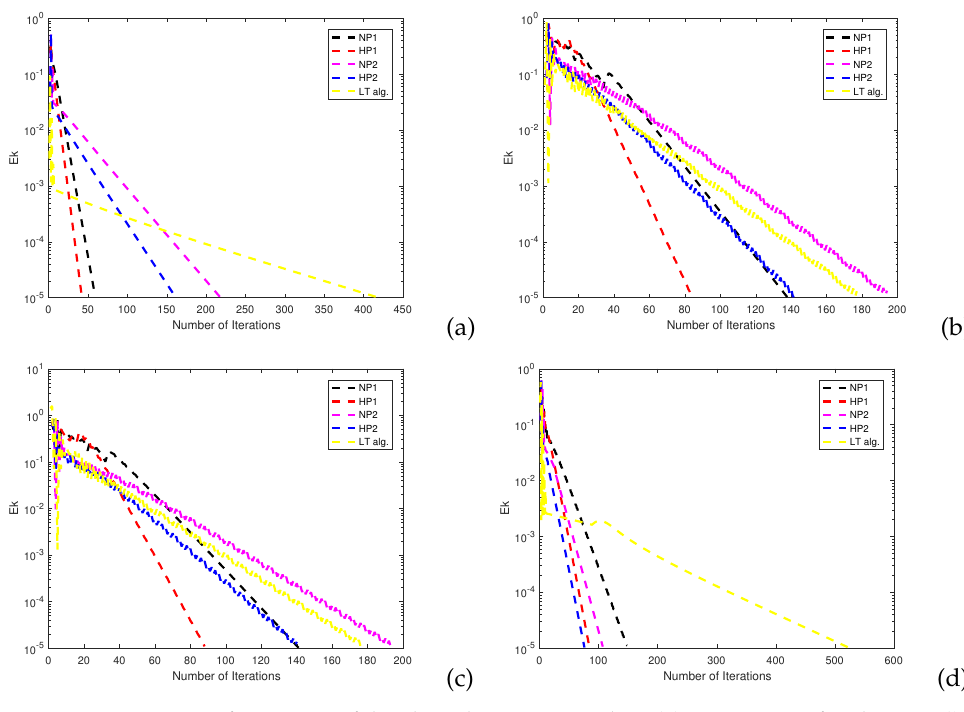
Figure 4. Comparison of iterations of the algorithms in Example 1: ( a ) Comparison for choice 1. ( b ) Comparison for choice 2. ( c ) Comparison for choice 3. ( d ) Comparison for choice